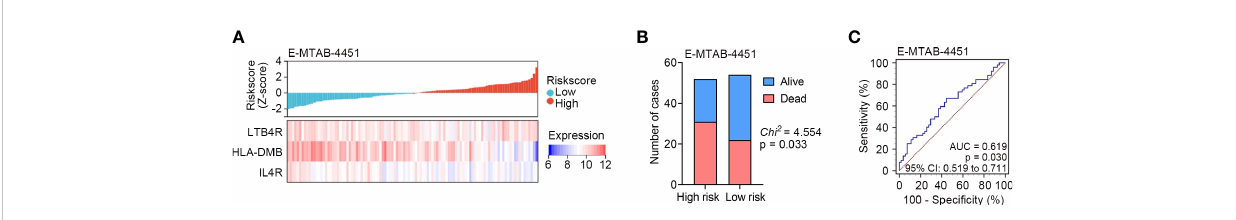
FIGURE 4 External validation of the identi fi ed IRG signature in E-MTAB-4451 (n = 106). (A) The distribution of risk scores derived from the IRG signature, and the expression of the three genes that comprised the IRG signature in E-MTAB-4451. (B) The distribution of 28-day survival status in the high risk (n = 52) and low risk (n = 54) subgroups in E-MTAB-4451. (C) ROC analyses of the sensitivity and speci fi city of 28-day mortality prediction by the IRG signature in E- MTAB-4451. P value was obtained from the comparison of the AUC of the IRG signature risk score versus whose classi fi cation by 0.5